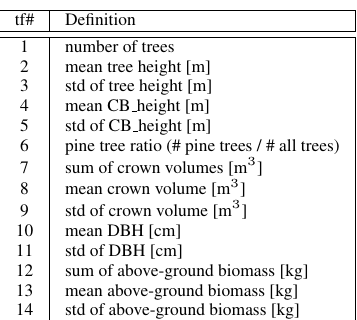
Table 1. Definition of tree features (tf)